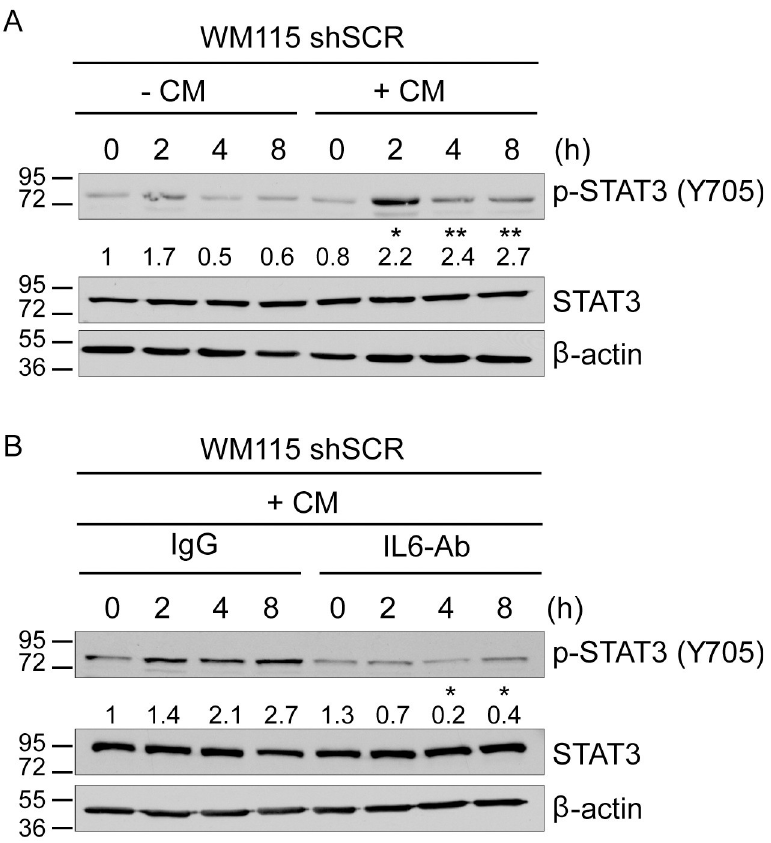
Fig 4. Restoration of p-STAT3 by the knockdown of S100B occurs via IL6 autocrine activity. A schematic design of this experiment is also available (S4 Fig). (A) Immunoblot analysis was done on shSCR WM115 cells after 0, 2, 4, and 8 hours of treatment with either shS100B cell conditioned media (shS100B CM) or control media. The conditioned media increases p-STAT3 as compared to the control (n = 3; mean ± SD; � , P < 0.05, �� , P < 0.005). (B) shSCR WM115 cells were cultured with shS100B CM in the absence/presence of an IL6 inhibitory antibody (IL6 Ab; 0.15 μ g/ mL). Immunoblot analysis of p-STAT3 (Tyr705) and total STAT3 after 0, 2, 4, and 8 hours of treatment shows the IL6 Ab prevents increased p-STAT3 production compared to an equivalent concentration of a non-specific control IgG (n = 3; mean ± SD; � , P < 0.05). Relative p-STAT3 protein levels were quantified using Image J software. showed that S100B directly binds and blocks RSK nuclear localization independent of MEK activation [8]. Therefore, to address whether or not RSK was also involved in the S100B- dependent repression of IL6 expression, a small molecule RSK inhibitor (BI-D1870) was administered to shSCR and shS100B WM115 cells (Fig 5). Interestingly, BI-D1870 treatment reduced IL6 mRNA and secreted protein levels quickly ( < 2 hr) in shS100B WM115 cells when compared to shSCR WM115 control cells (Fig 5A and 5B). Phosphorylation of STAT3, which is downstream of IL6 production, was also decreased upon RSK-inhibition with no effect on total STAT3 levels (Fig 5C and 5D). To confirm the reduced level of IL6 mRNA from BI-D1870, a second inhibitor selective for RSK, SL0101, was administered to WM115 mela- noma cells. Similarly, SL0101 treatment also decreased IL6 mRNA levels in the shS100B WM115 cells, and it did so much more robustly than shSCR WM115 cells (Fig 5E). Since CREB is a known substrate of RSK [34] and because it is a transcriptional activator for IL6 expression [35], its role in the S100B-dependent regulation of IL6 was examined next. Interestingly, silencing S100B expression in WM115 cells caused a large increase in CREB